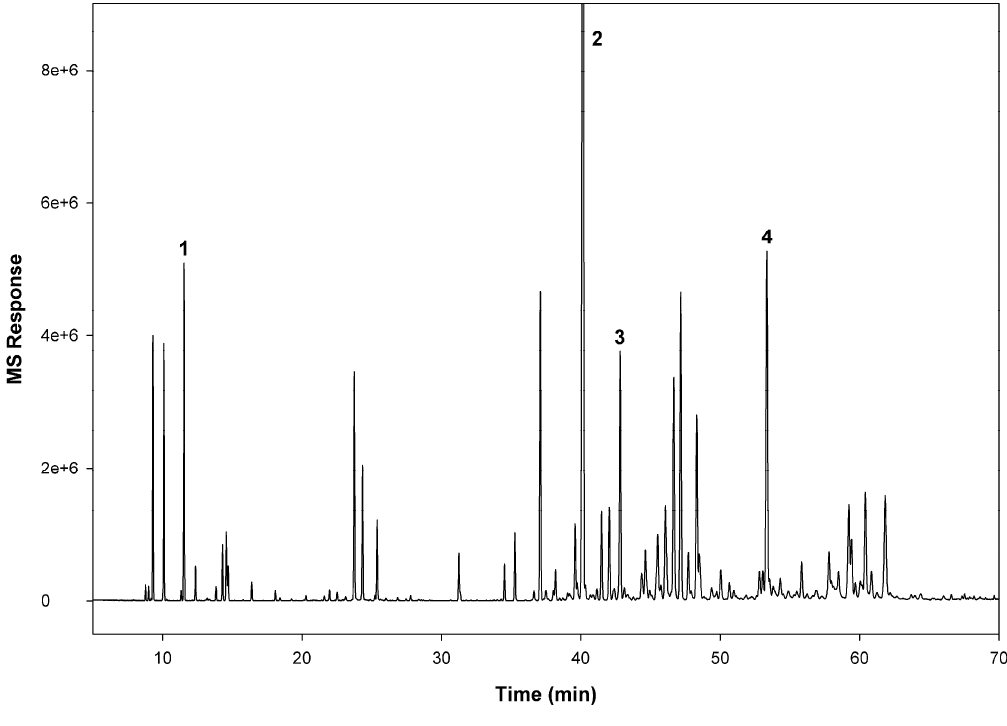
Figure 2. Total ion chromatogram of Kadsura coccinea essential oil. Compound identification: ( 1 ) β -pinene; ( 2 ) β -caryophyllene; ( 3 ) α -humulene; and ( 4 ) caryophyllene oxide. Table 1. Mean (±SE) mortality produced by essential oil of Kadsura coccinea “EOKC”, applied topically on two strains of bed bug.